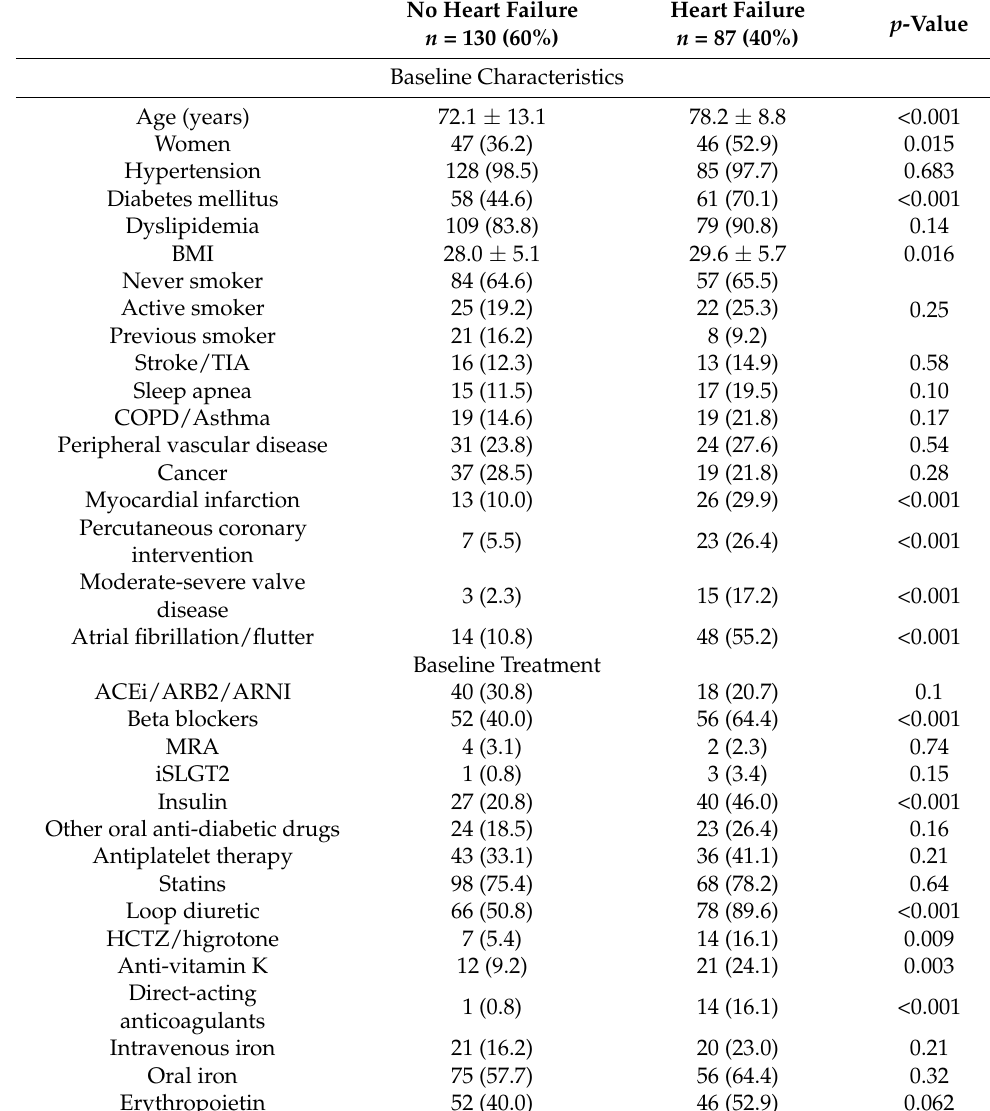
Table 1. Baseline characteristics between patients with and without heart failure at inclusion.